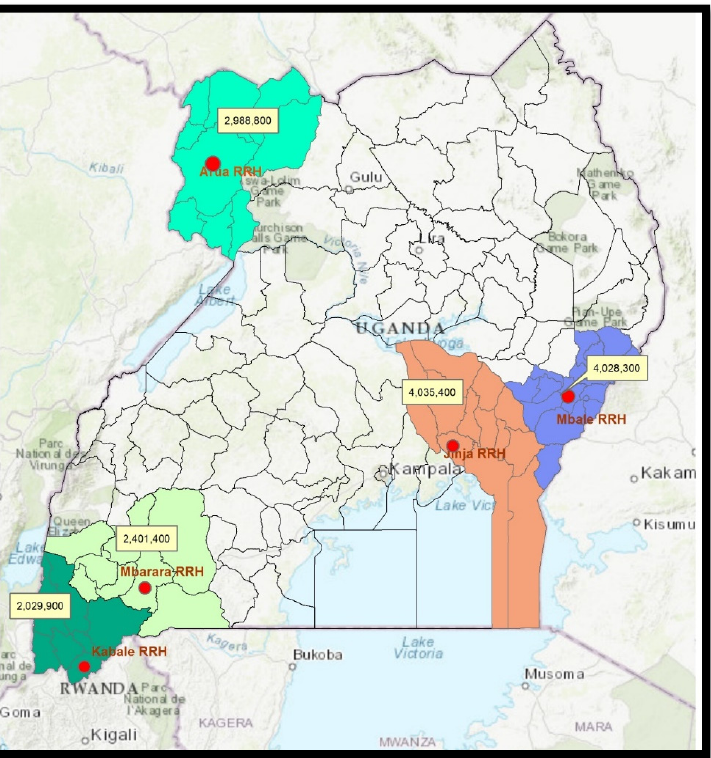
Figure 1. Map showing the distribution of the five AMR surveillance sites and population density for each location in Uganda. Note: The different color coding indicates separate location demon- stration.